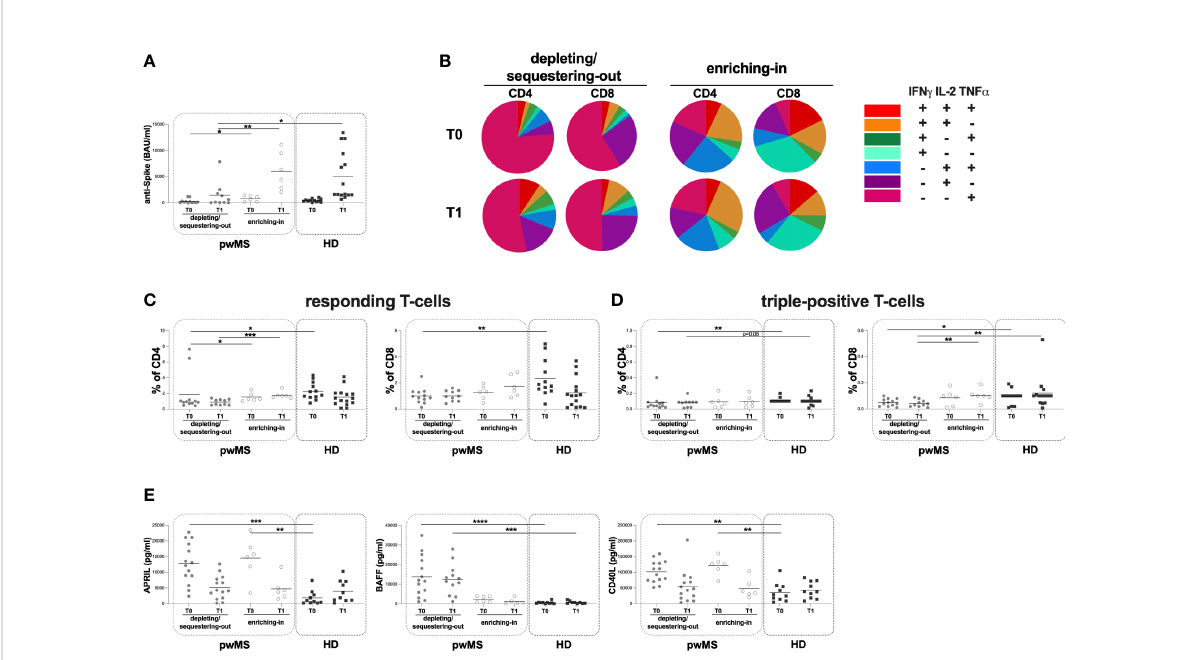
FIGURE 4 Cross-sectional evaluation of humoral and speci fi c T-cell response is pwMS subgroups and HD, and overview of cytokine-producing T-cells. (A) The evaluation of anti-S antibody titers at two time-points: T0 and T1 in the depleting/sequestering-out and the enriching-in subgroups, and HD. (B) Overview of intracellular IFN g , IL2 and TNF a production by CD4+ and CD8+ T-cells at T0 and at T1 in the depleting/sequestering-out and the enriching-in subgroups. (C) Evaluation of responding CD4+ and CD8+ T-cells in pwMS subgroups and HD. (D) Evaluation of triple-positive CD4+ and CD8+ T-cells in pwMS subgroups and HD. (E) Evaluation of plasma levels of APRIL, BAFF and CD40L in the depleting/ sequestering-out and the enriching-in subgroups, and HD. APRIL, A-proliferation inducing ligand; BAFF, B-cell activating factor; CD40L, CD40 ligand; pwMS, people with multiple sclerosis; HD, healthy donors; T0, before third dose of vaccine; T1, after two months form third dose of vaccine. *p < 0.05; **p < 0.01; ***p < 0.001; ****p <